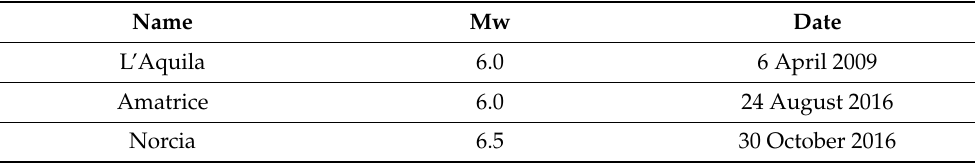
Table 3. The Mw6 mainshock registered in the ISIDE seismic